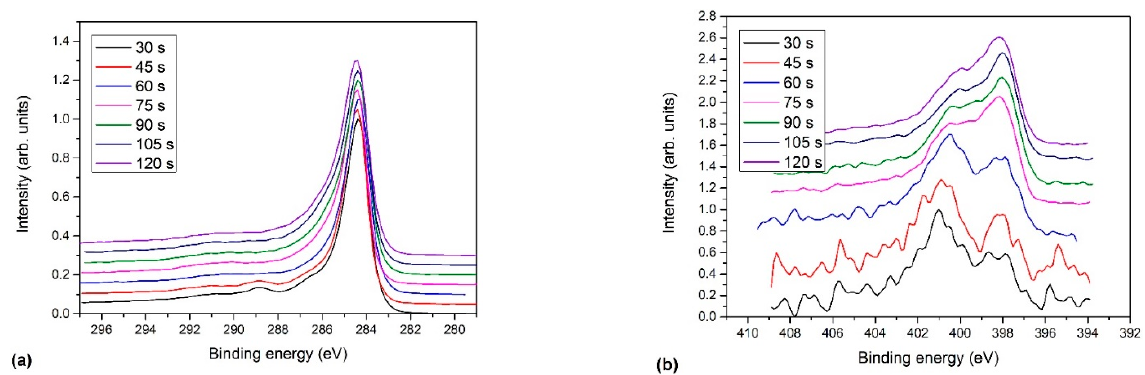
Figure 6. Evolution of: ( a ) high-resolution C1s, and ( b ) N1s spectra of N-doped carbon nanomesh versus deposition time.